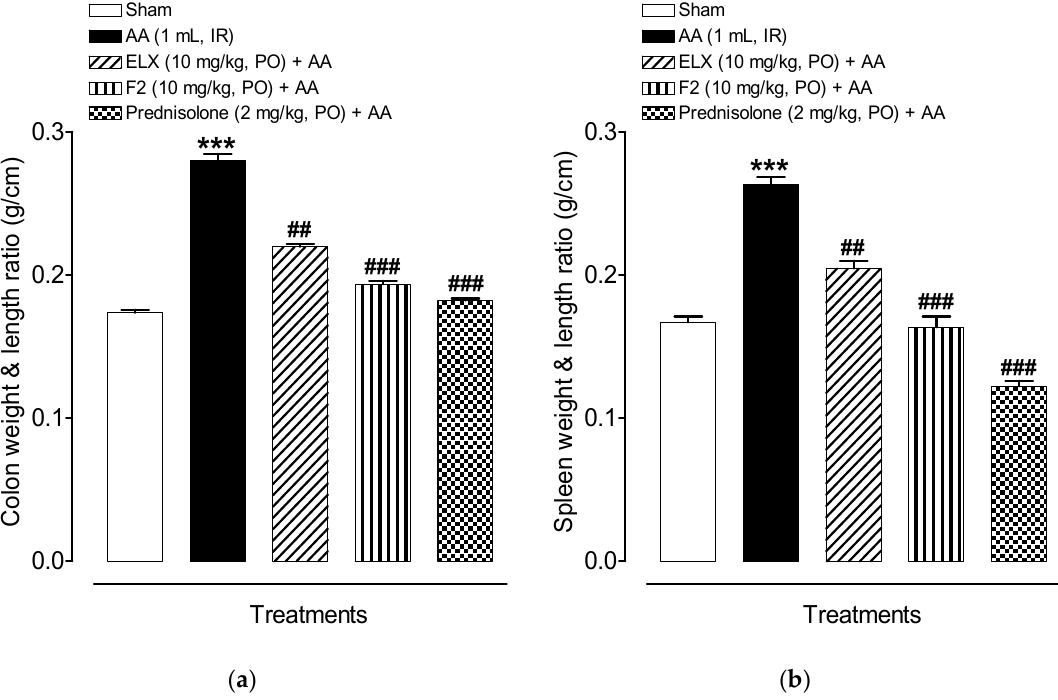
Figure 7. Pre-treatment with ELX and F2 decreased ( a ) colon wet weight and length ratio, and ( b ) spleen wet weight and length ratio in Wistar albino rats induced with AA colitis. Data are represented as means ± SEM ( n = 6). *** p < 0.001 compared with sham group; ## p < 0.01, ### p < 0.001 compared with AA alone. ELX = Eluxadoline, F2 = formulation, AA = acetic acid; PO = orally; IR = intrarectally.